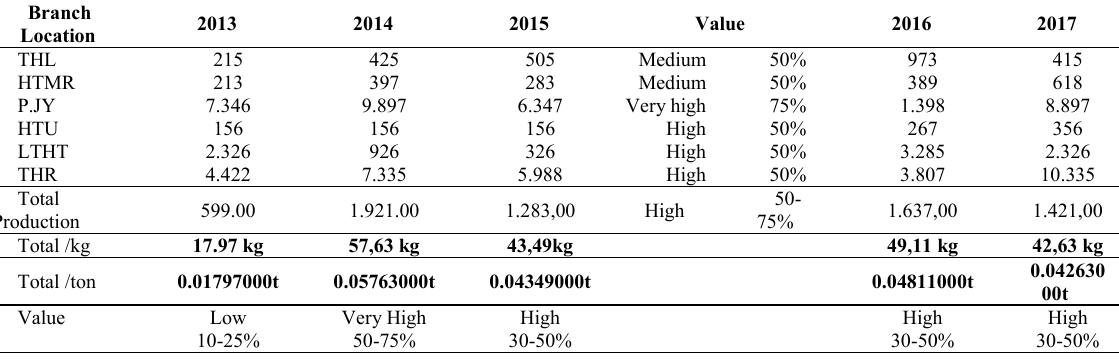
TABLE 5 T OTAL , VALUE , AND PRODUCTION RESULT OF THE COMPANY / YEAR BASED ON T YPE OF P RODUCT